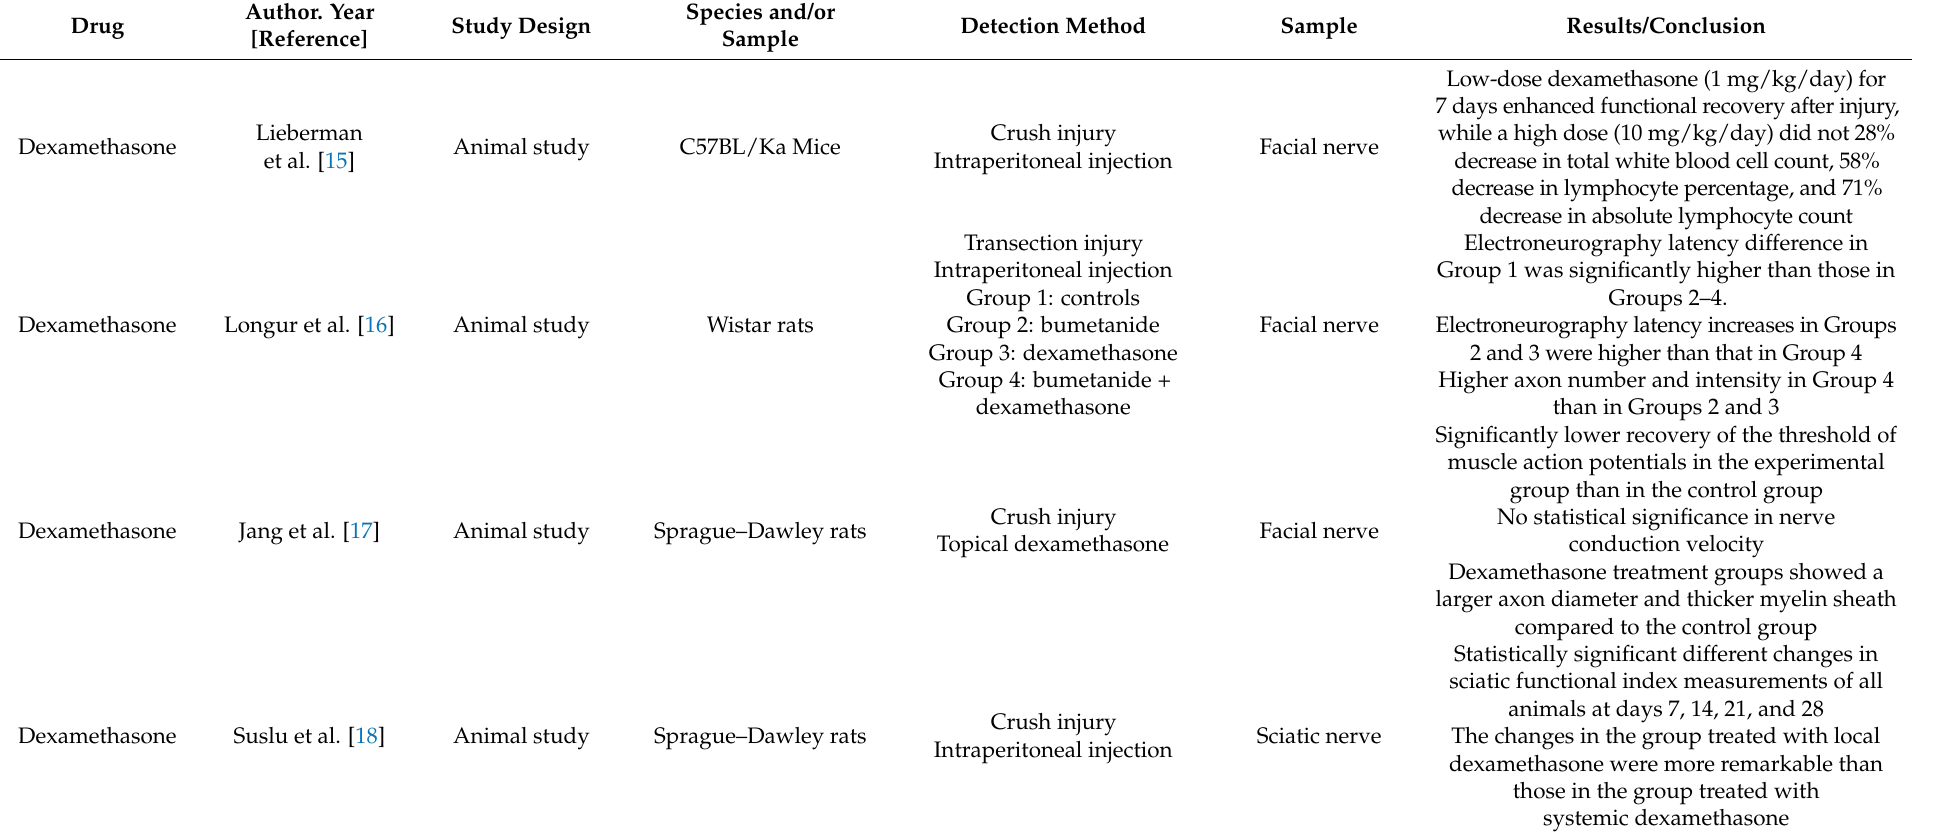
Table 2. Summary of studies on steroids for the treatment of peripheral nerve